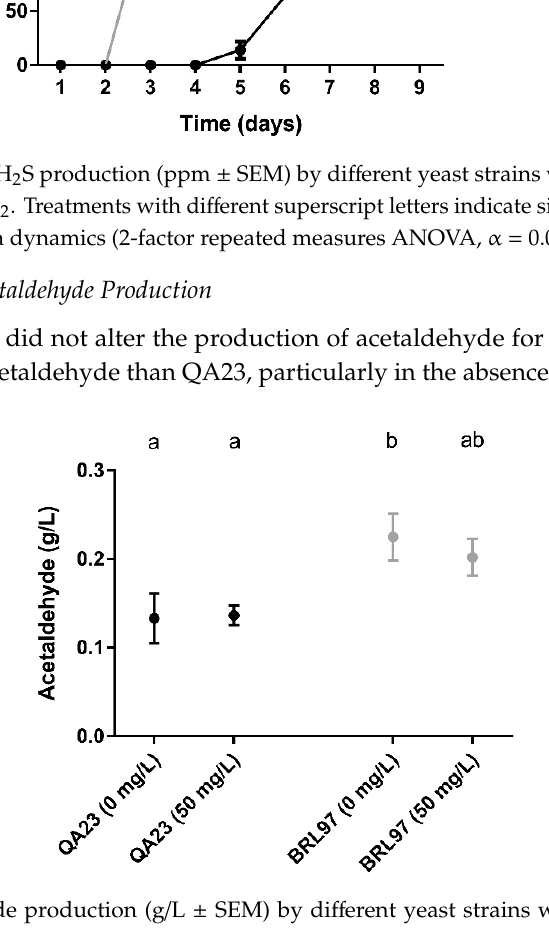
Figure 5. Acetaldehyde production (g/L ± SEM) by different yeast strains when fermented in the presence of 0 or 50 mg/L SO 2 . Different letters written above each treatment indicate significant differences in acetaldehyde concentration (2-factor ANOVA, α = 0.05).